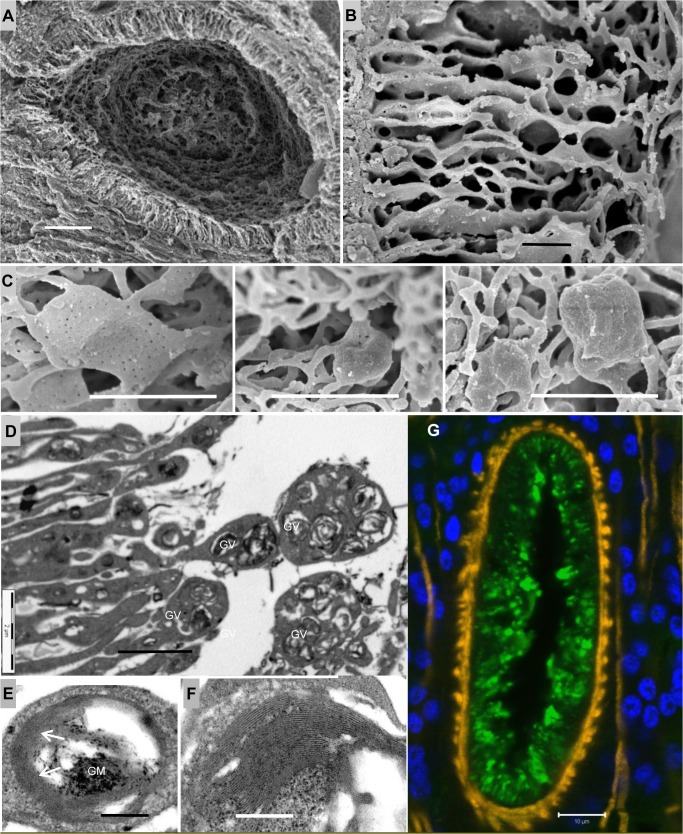
Vesicle release in the anterior esophagus of worms from rhesus macaques is disrupted.(A) SEM of a transverse thick section of a worm head, displaying an internal view of the anterior esophagus. The lining corrugations appear short and shrunken; (B) High magnification SEM showing the honeycomb appearance of anterior corrugations, which look more fragile than in normal worms; (C) Three to-scale SEM images of flat plates of cytoplasm in the fringe of the anterior lining, obscured by a deposit of material. Their surface pits varied from ‘largely visible’ (left), through ‘barely seen’ (middle), to ‘completely obscured’ (right), giving the whole flat plate a lumpy spheroidal appearance. (D) TEM of the luminal edge of the anterior lining, showing its tips greatly expanded beyond the normal situation, and containing giant vesicles (GV). (E) TEM of a giant vesicle showing its contents include both granular material (GM) and membrane stacks (arrowed). (F) High magnification TEM reveals that the membrane stacks comprise alternating light and dark bands of material, resembling the membranocalyx-coating of the esophageal surface lining. (G) Confocal image of a transverse section of a worm head stained with AF488 labeled anti-monkey IgG (green), showing the focal and punctuate staining in the anterior lining; both intense spheroids of IgG staining and smaller, fainter spots are evident. DAPI-stained nuclei are blue and phalloidin-stained muscle is orange. Scale bars: 10 μm (A, G), 2 μm (B, C, D), 200 nm (E, F).